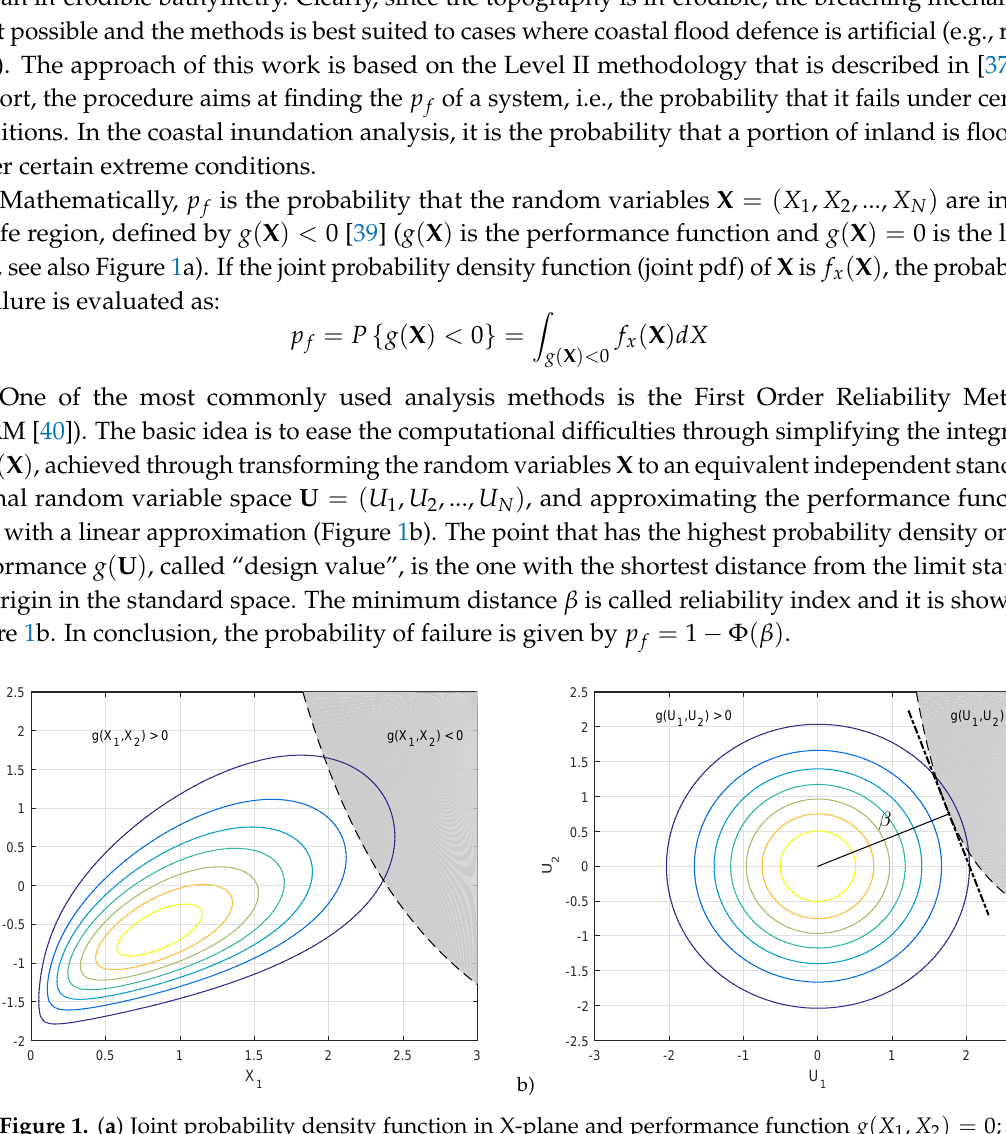
Figure 1. ( a ) Joint probability density function in X-plane and performance function g ( X 1 , X 2 ) = 0; and ( b ) joint pdf in U-plane and performance function g ( U 1 , U 2 ) =